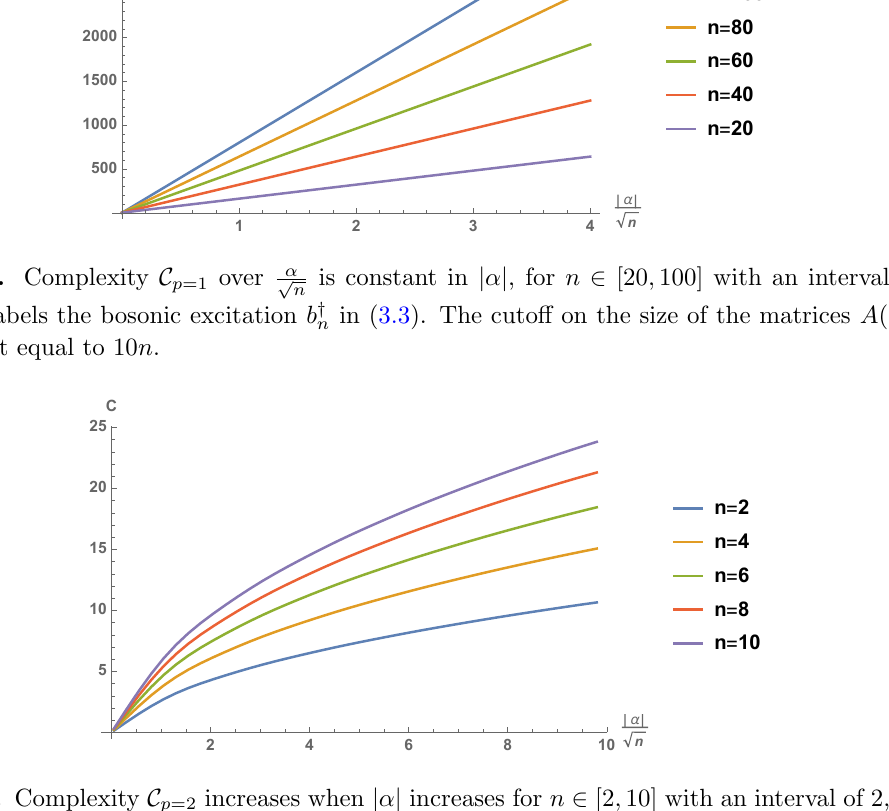
increases when (cid:11) increases for n [2 ; 10] with an interval of 2, where C p =2 j j 2 in (3.3). The length of the matrices A ( n ) and B ( n ) is cut to be n